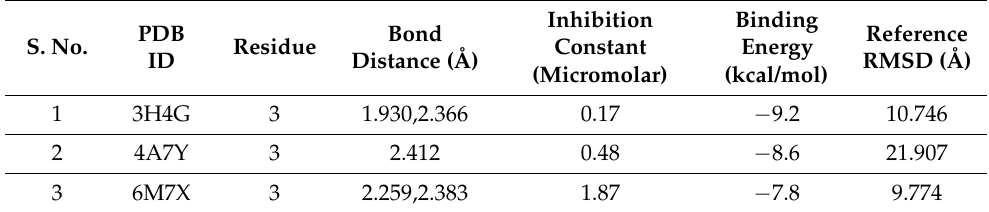
Table 9. Hydrogen bonding and molecular docking with Centromere associated protein inhibitor protein targets.